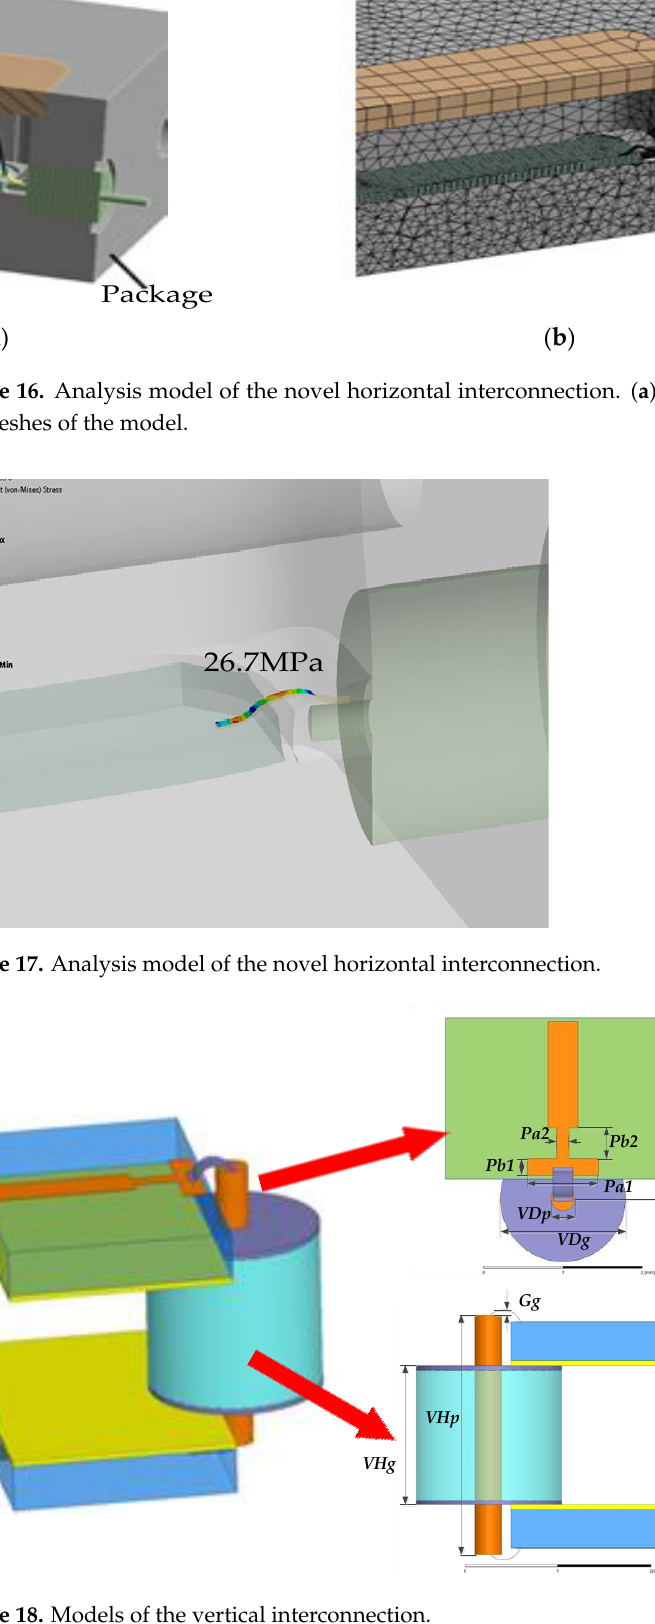
Figure 16. Analysis model of the novel horizontal interconnection. ( a ) The stress analysis model; ( b ) Meshes of the model